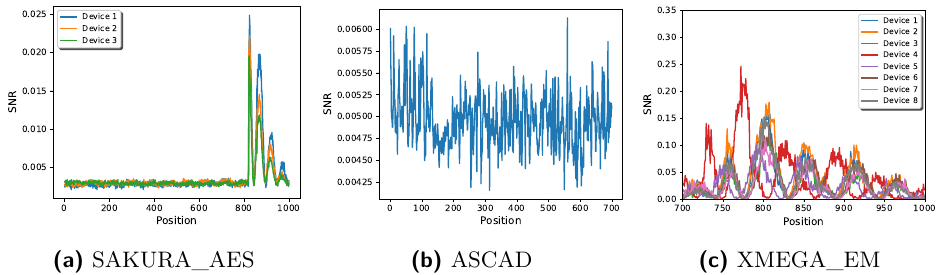
Figure 7: SNRs of several investigated